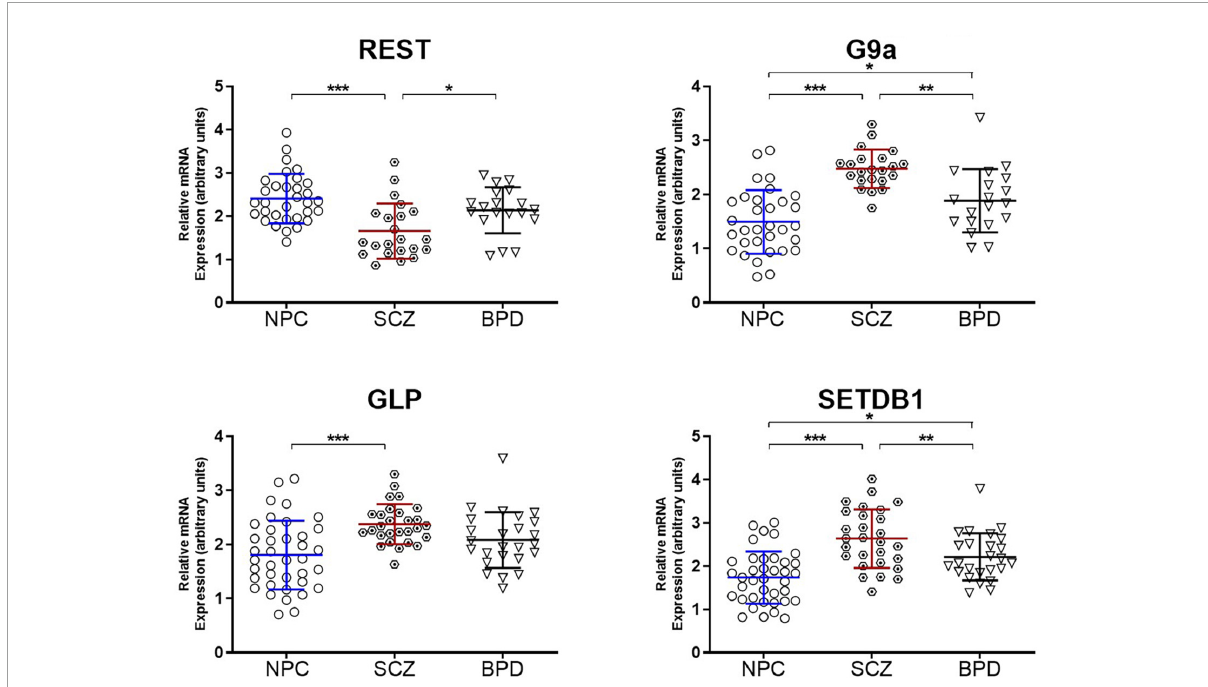
FIGURE3 Epigenetic enzymes underwriting heterochromatin formation. Relative mRNA expression levels in the PFC of Repressor element-1 silencing transcription factor (REST) and H3K9 histone methyltransferases (G9a, GLP, and SETDB1). Data is shown as fold change (FC) ± S.E.M. (error bars) after normalization to GAPDH and case compared to NPC. NPC ( n = 32), individuals with SCZ ( n = 22), individuals with BPD ( n = 19). * p ≤ 0.05, ** p ≤ 0.01, *** p ≤